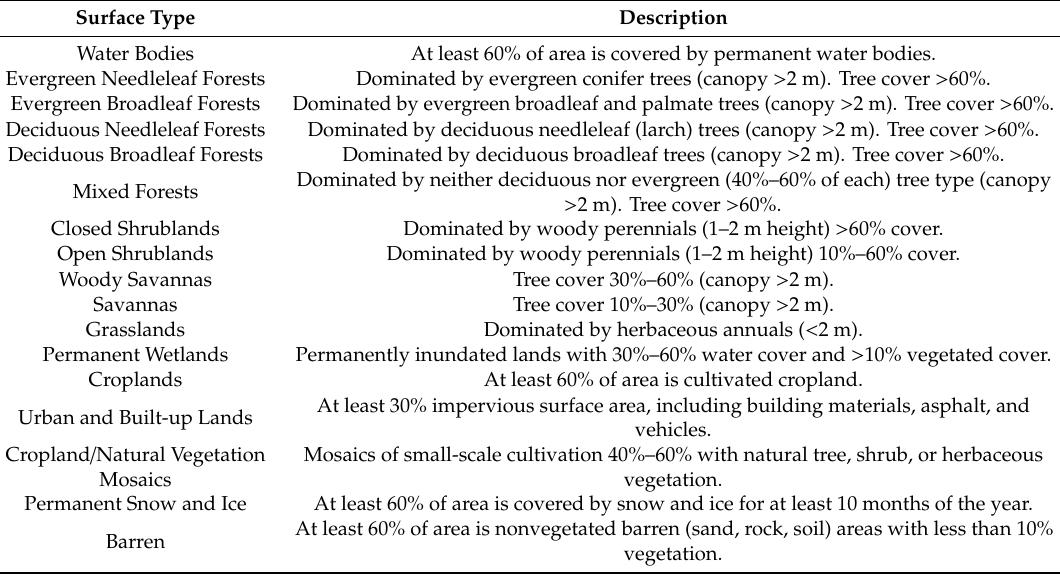
Figure 1. Distribution of the 95 selected sites from the FLUXNET2015 dataset and International Geosphere-Biosphere Programme (IGBP) surface types. Table 1. IGBP land cover classification classes and descriptions.